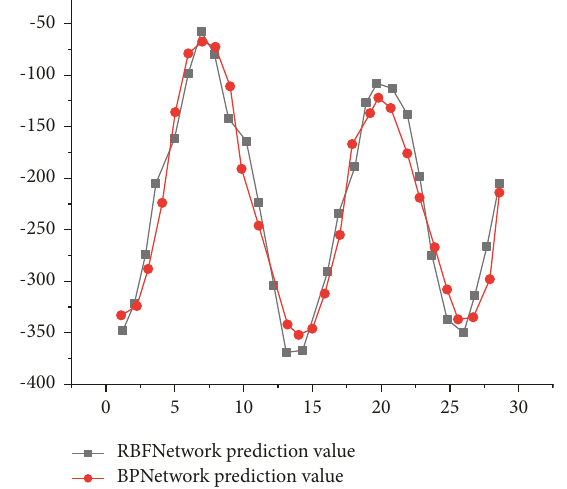
Figure 4: Comparison of RBF network predicted value and BP network predicted